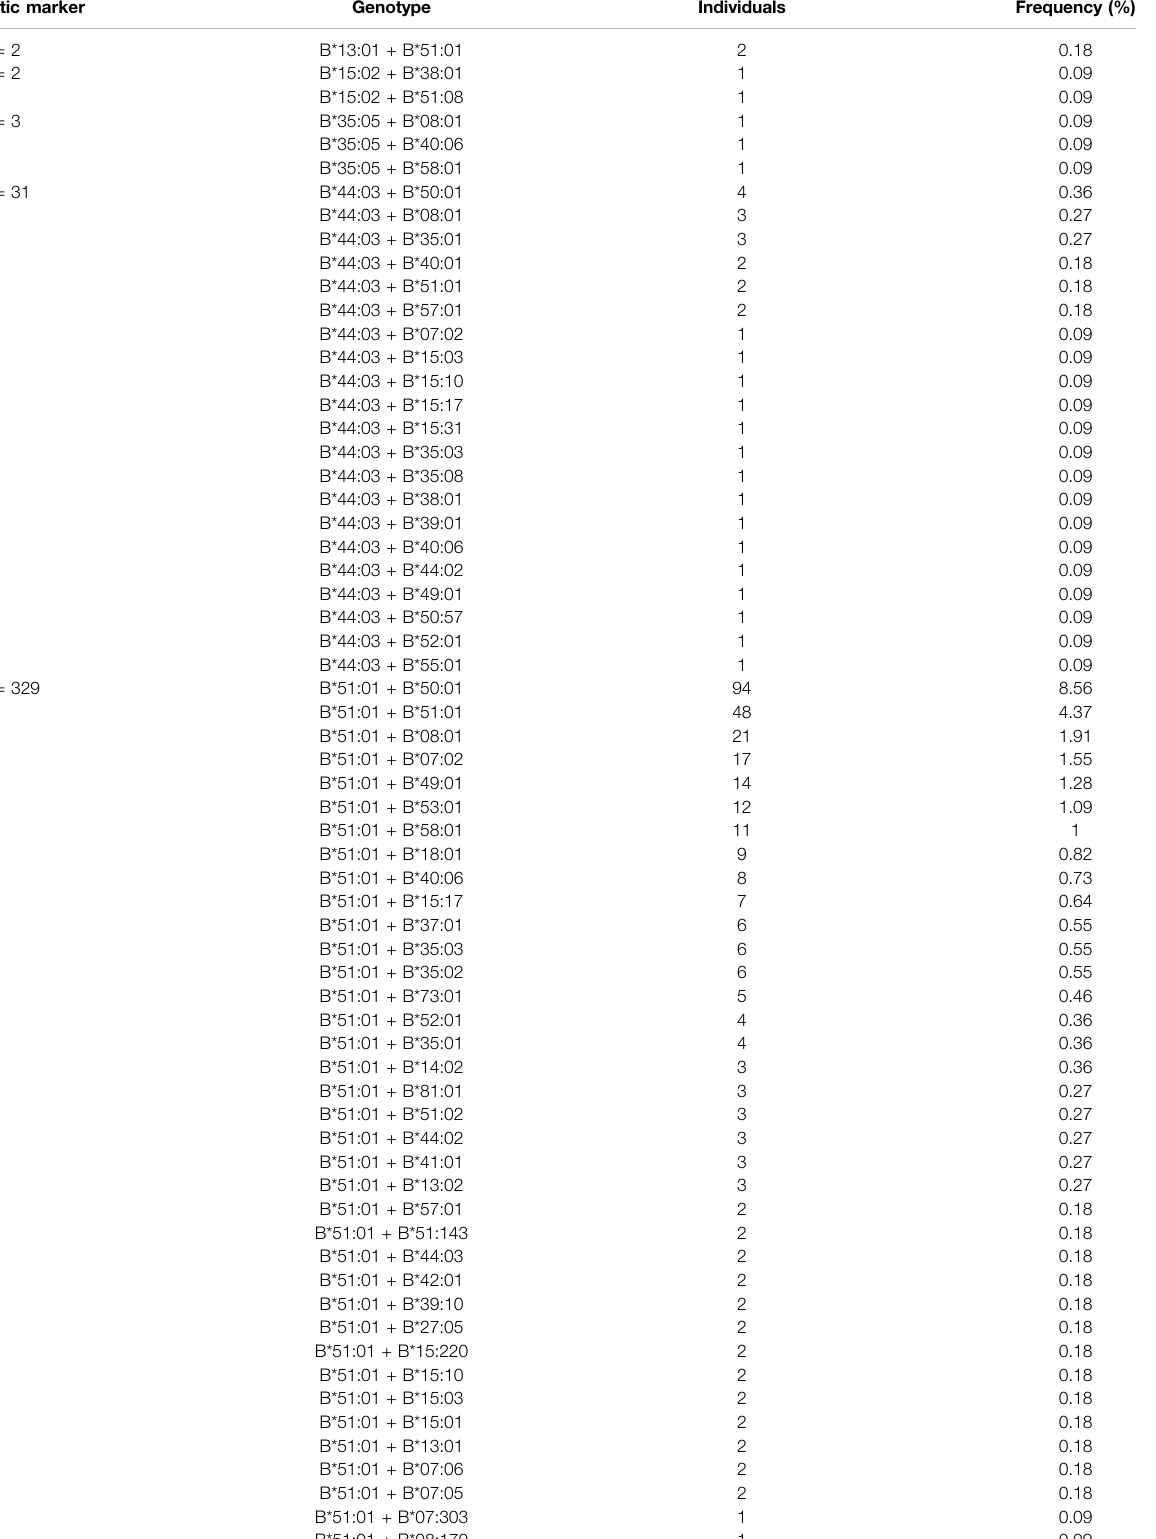
TABLE 4 | Genotype frequency of major HLA-B pharmacogenetics markers in Qatari